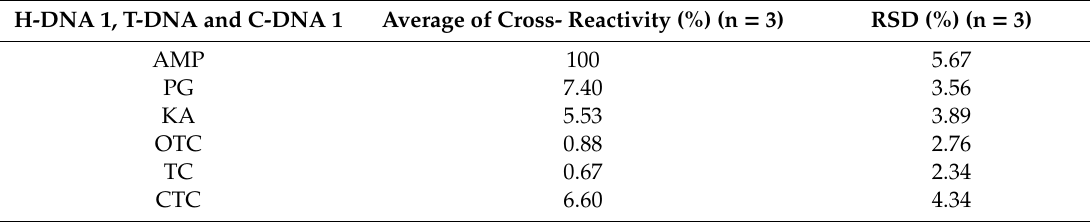
Table 1. Cross-reaction of some antibiotics with H-DNA 1, T-DNA and C-DNA 1 in the proposed CF-LFI system.